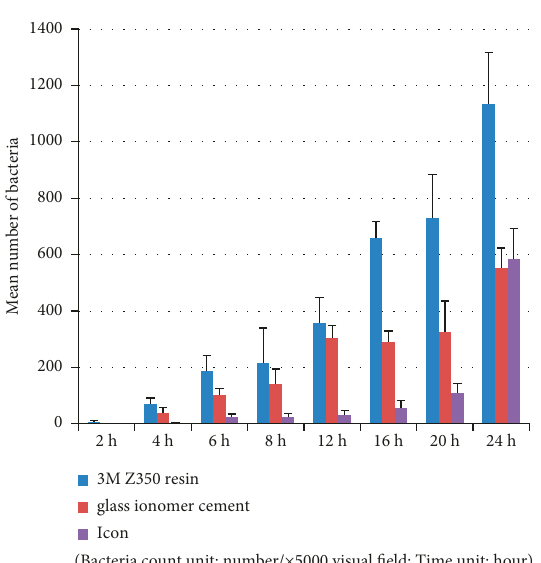
Figure 4: Actinomyces viscosus group (plate colony counting).